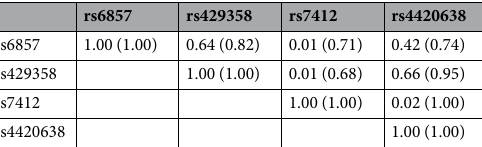
Table 2. Measures of linkage disequilibrium between variants at the APOE locus. Linkage disequilibrium estimates taken from European 1000 Genomes for variants within the APOE locus: r 2 and D ′ (in brackets). Variants shown are as follows: rs6857: Peak variant from the IGAP meta-analysis, rs429358: Variant comprising the APOE ε 4 allele, rs7412: Variant comprising the APOE ε 2 allele, rs4420638: Peak variant from the CARDIoGRAM plus C4D